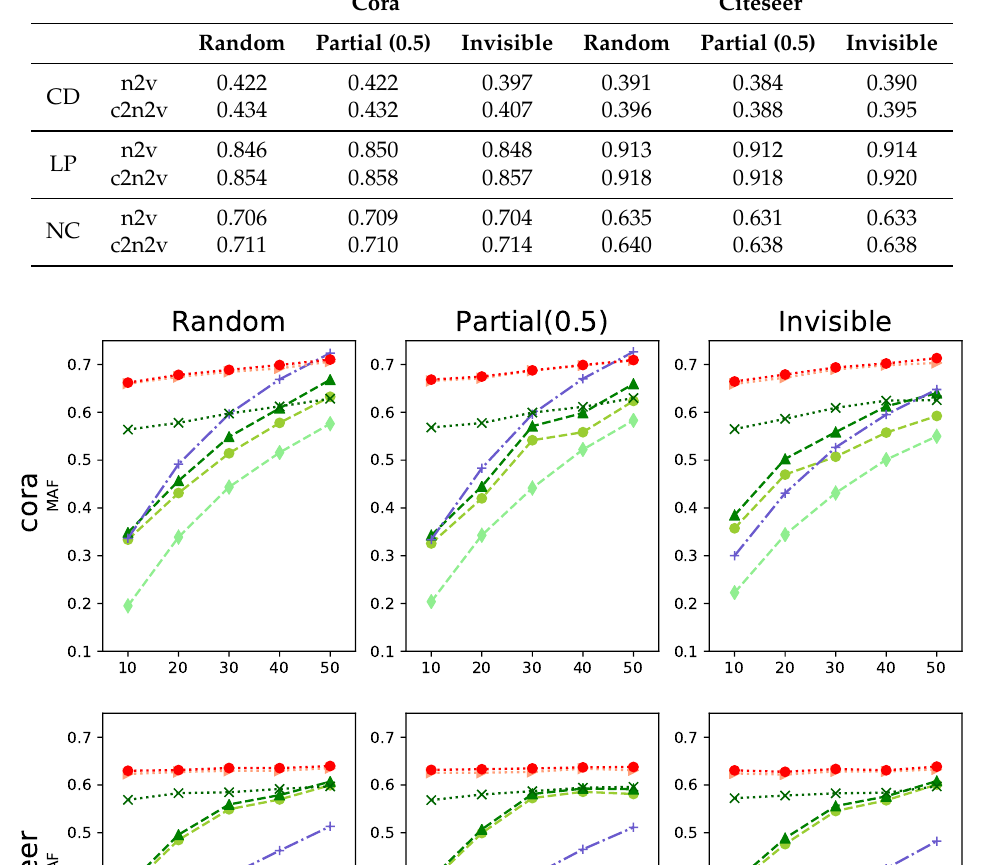
Table 2. Comparison between n2v and c2n2v with structure-attribute enhanced matrix (SAEM). Cora Citeseer Partial (0.5)